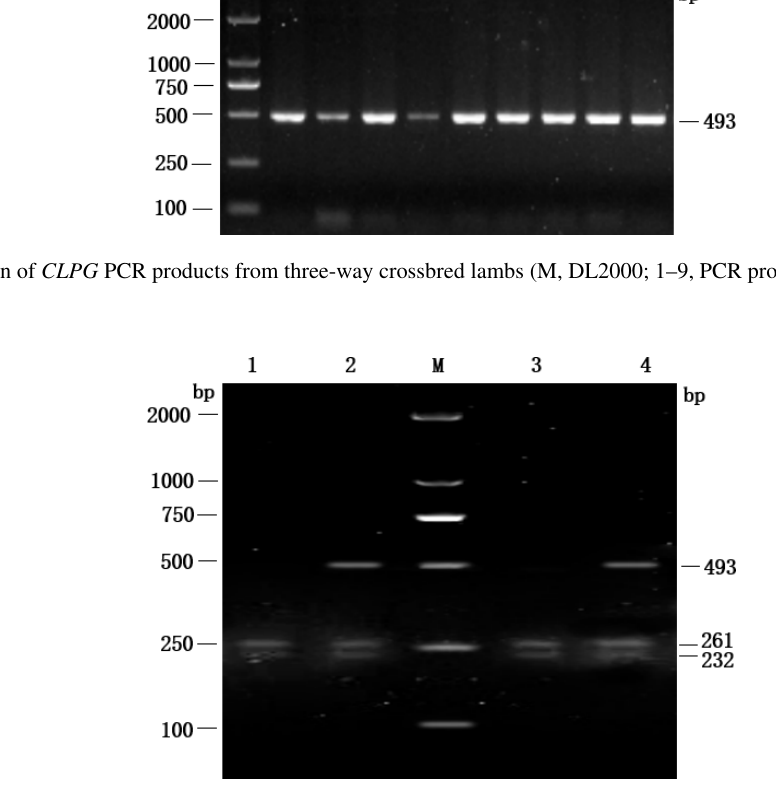
Figure B2. Digestion of CLPG PCR products from three-way crossbred lambs (M, DL2000; 1–4, digestion products; 1 and 3, CC individuals; 2 and 4, CT